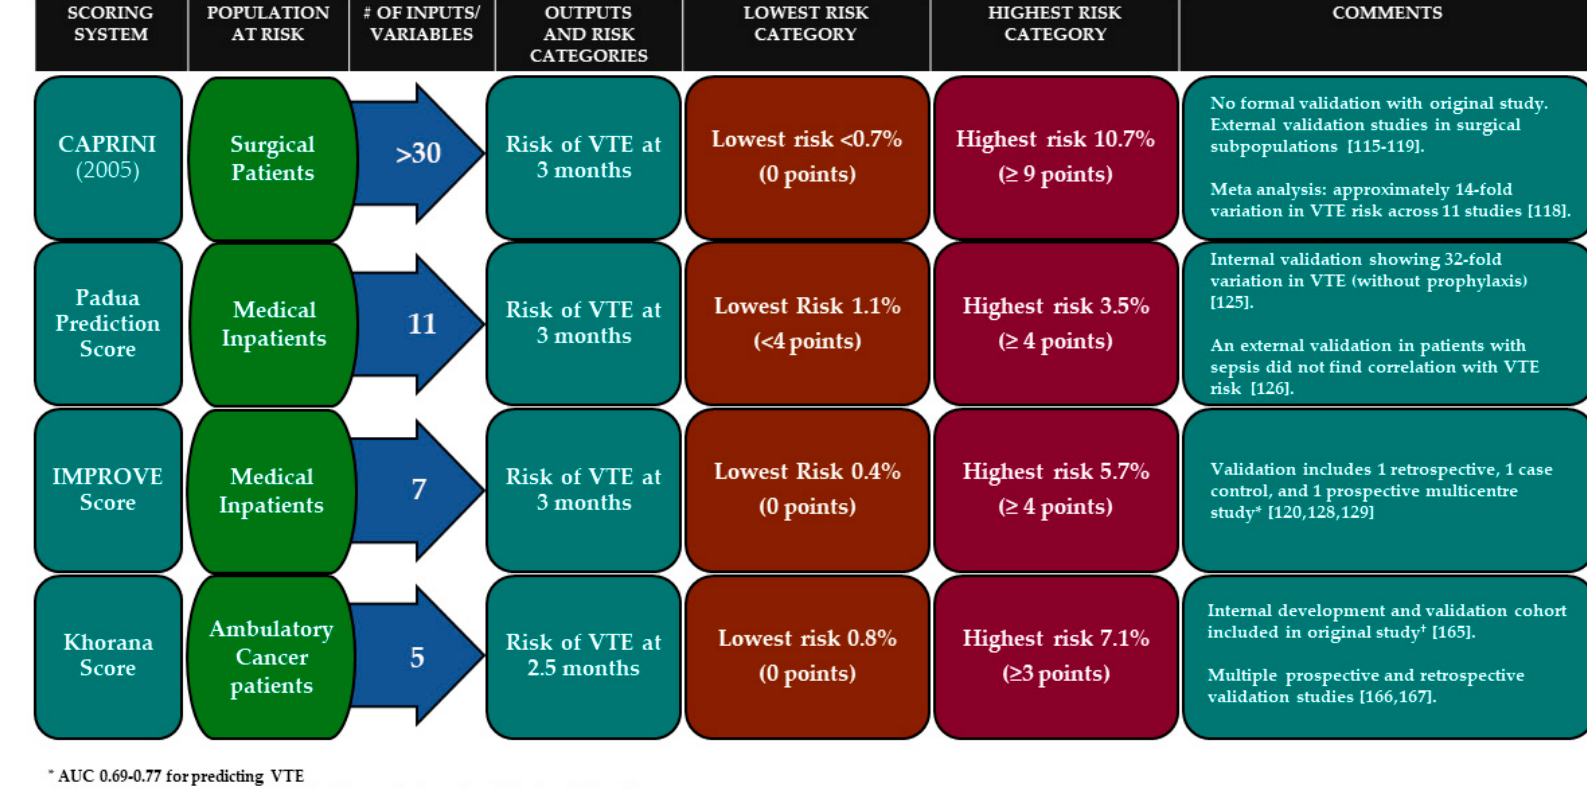
Figure 1. Summary of select scoring systems for predicting risk of venous thromboembolism.